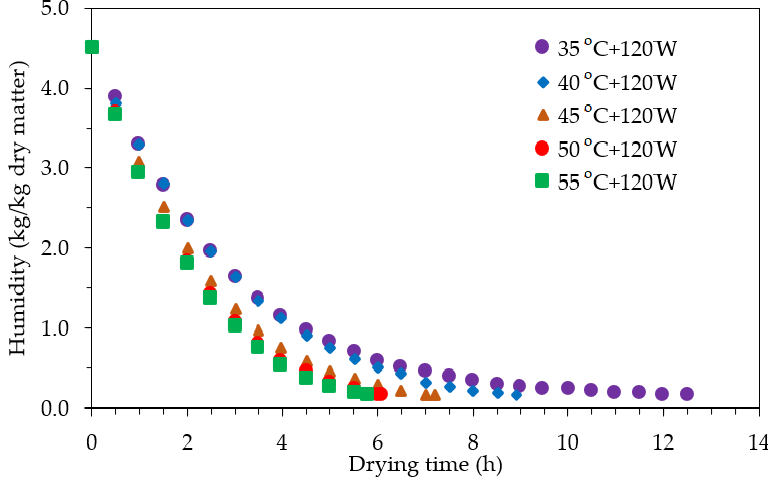
Figure 3. Drying curves at different temperatures with 120 W ultrasonic power.